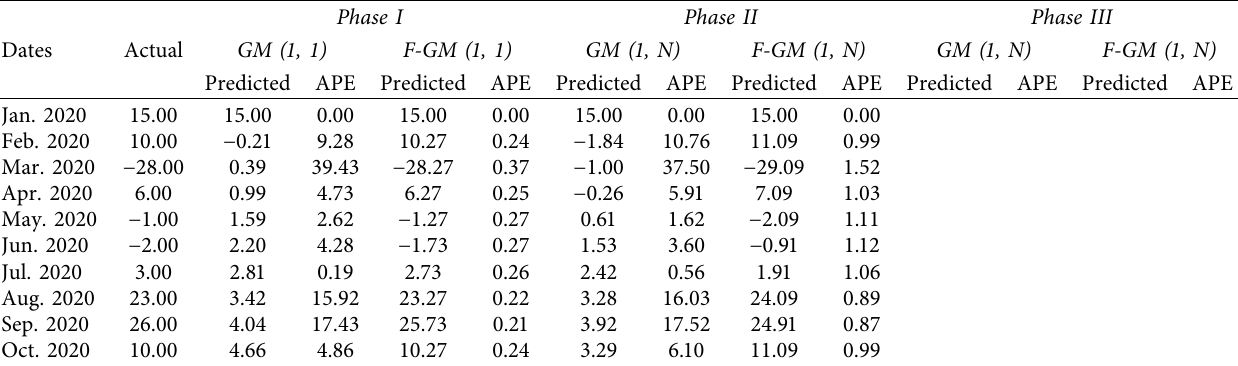
Table 13: Prediction results of travel sentiment in